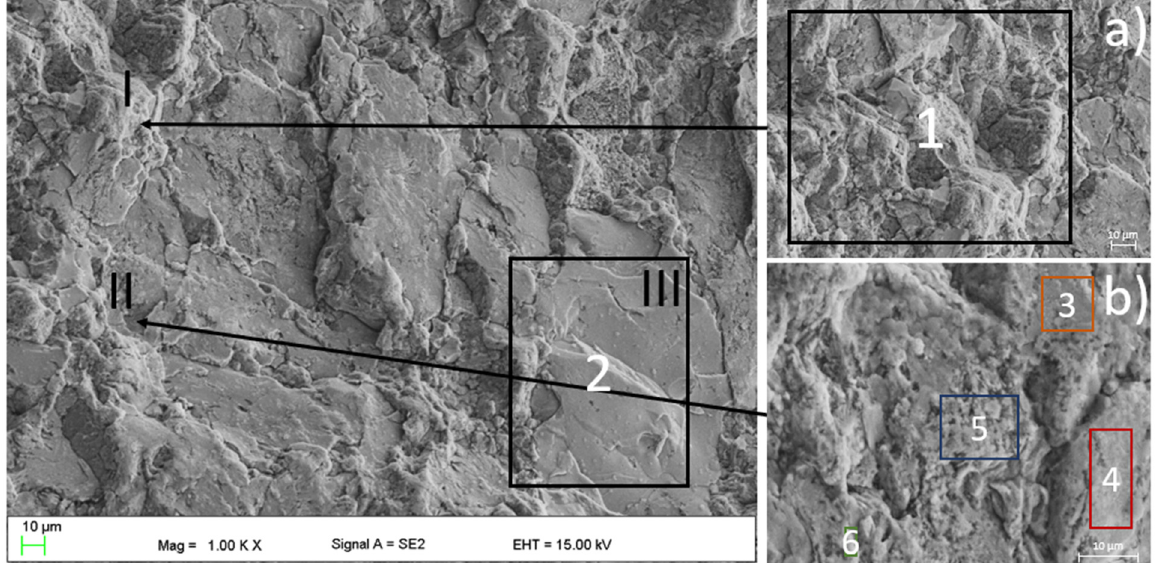
Figure 4. The SEM image with featured regions of the EDS analysis (marked with the Arabic numerals, the EDS values shown in the Table 2) obtained for the sintered Mg 63 Zn 30 Ca 4 Au 3 alloy. Area marked with “I” and “II” refers to the ( a ) and ( b ) images, respectively, where the intercrystalline fractures can be seen. The region marked as “III” is presented in Figure 5. Table 3. EDS results from the areas marked in Figure 4.